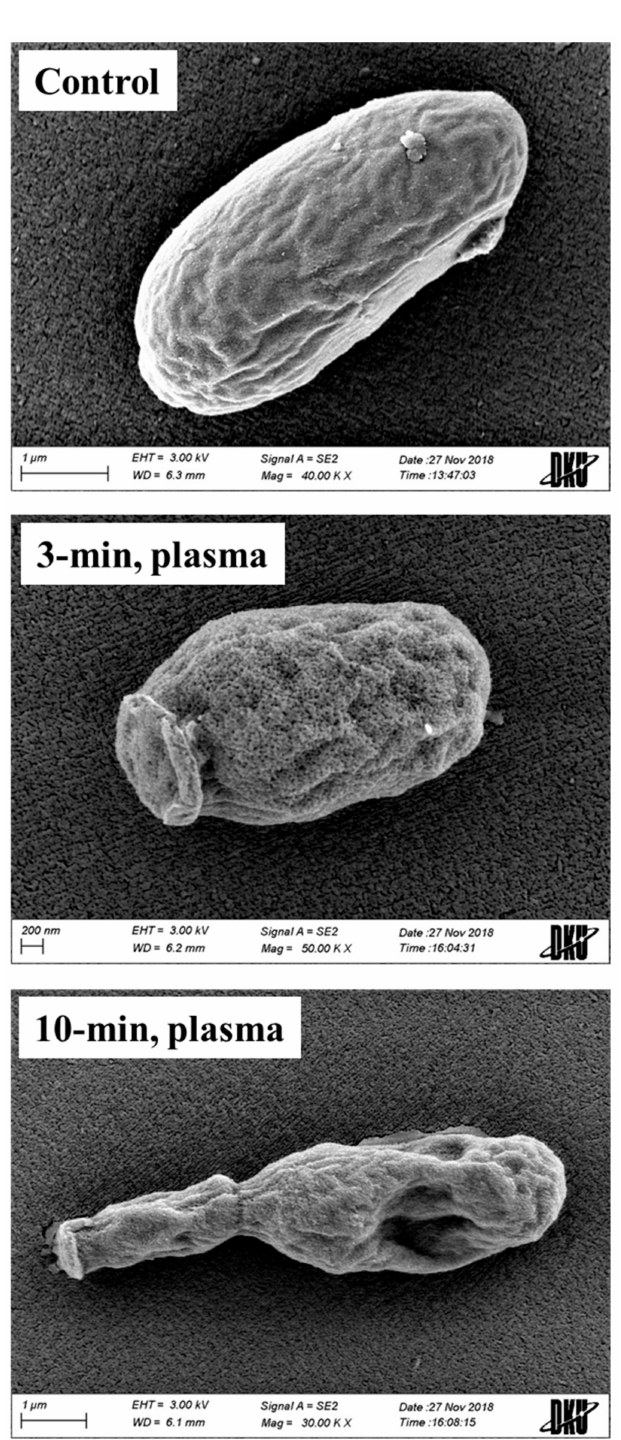
Figure 5. Typical SEM images of C . pruinosa spores treated by a soft plasma jet. C, 3, and 10 represent SEM images of the control, 3 min, and 10 min plasma-treated spores,